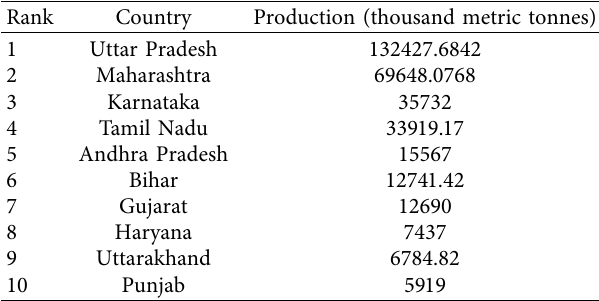
Table 3: Top 10 sugarcane-producing states in India